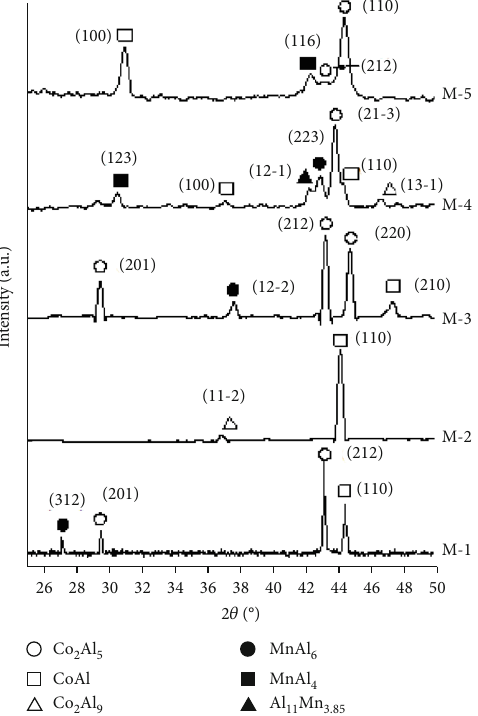
Figure 13: X-ray di ff raction analysis for the Aluminum-based alloy M1, M2, M3, M4 and M5 doped with Co and Mn as cast.